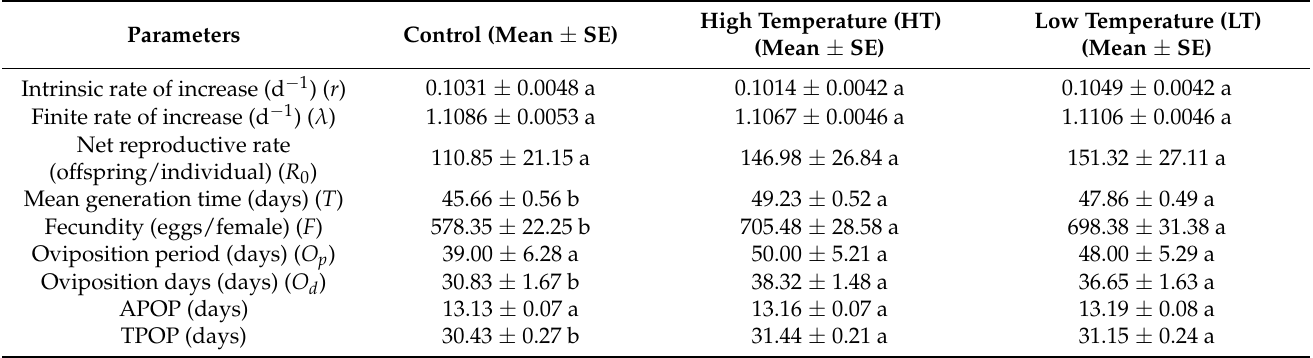
Table 2. Impact of high temperature (HT) and low temperature (LT) on the demographic and fecundity parameters of Bactrocera zonata